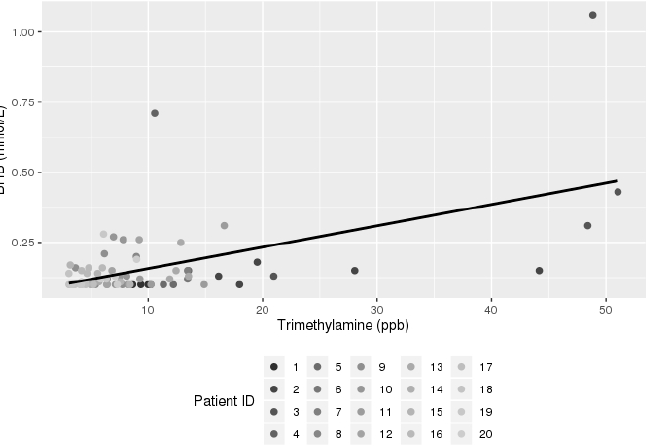
Figure 2. Scatter plot for breath TMA vs. serum ketones (BHB). Dots with the same color shade belong to the same patient.